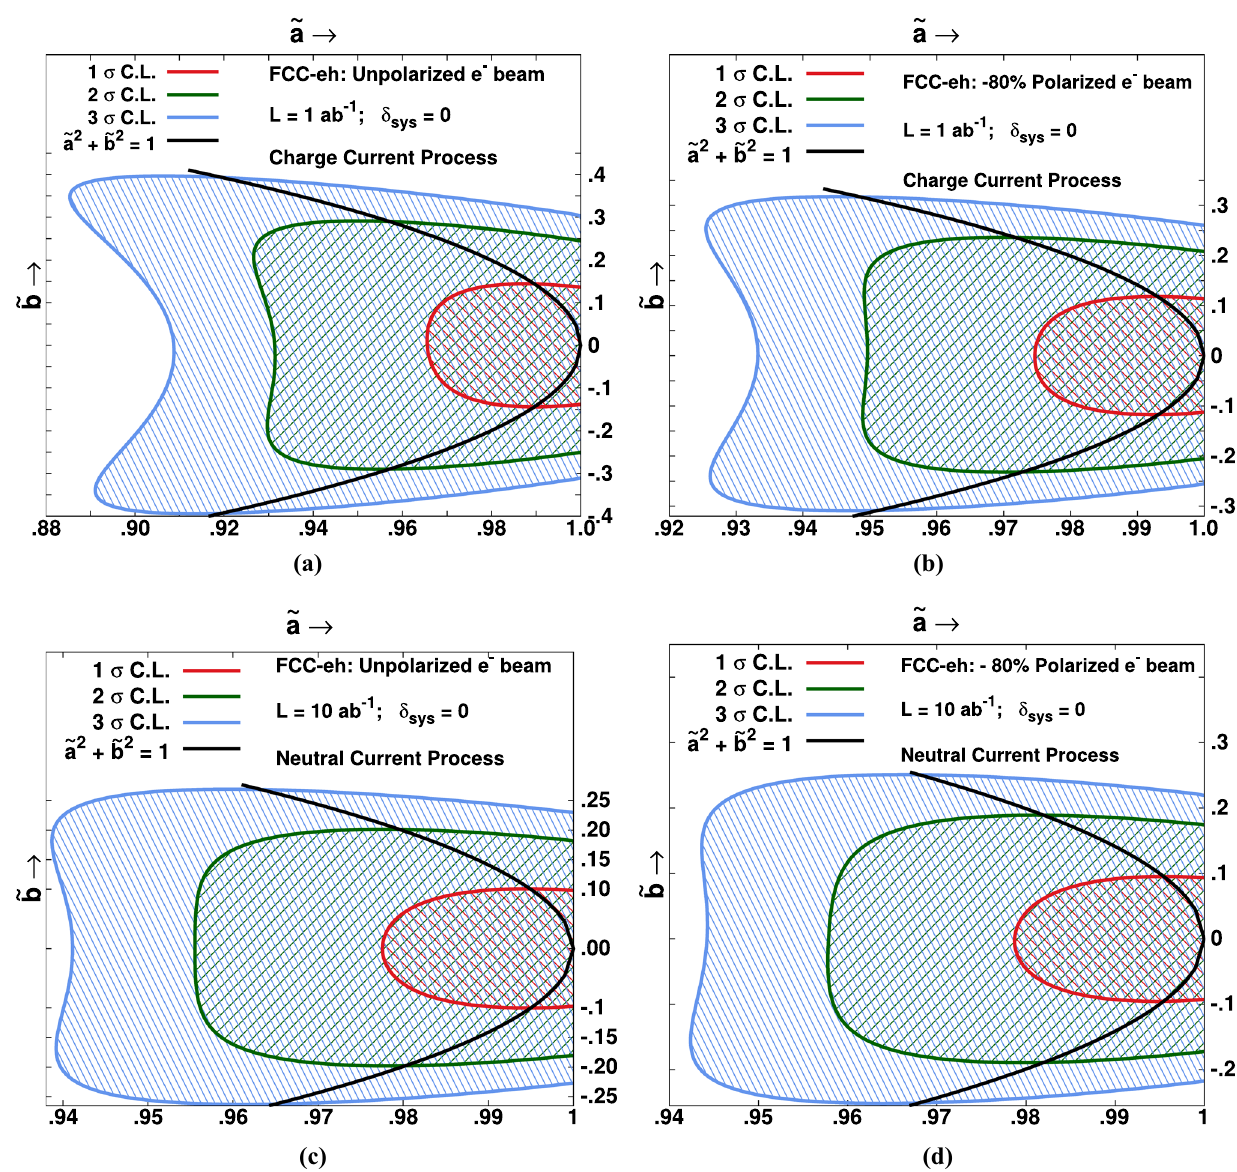
Fig. 5 68% (in red), 95% (in green) and 99.7% (in blue) CL exclusion contours are drawn in ˜ a − ˜ b plane using differential bin-width (cid:14)α CP = 30 ◦ . In each panel the intersecting points of the black contour with